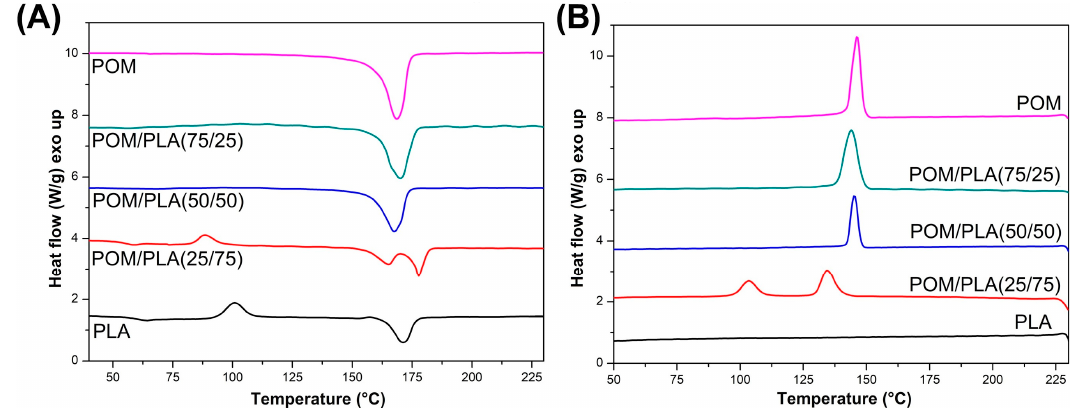
Figure 12. The results of di ff erential scanning calorimetry (DSC) measurements for POM / PLA blends: ( A ) first heating thermograms and ( B ) cooling thermograms.